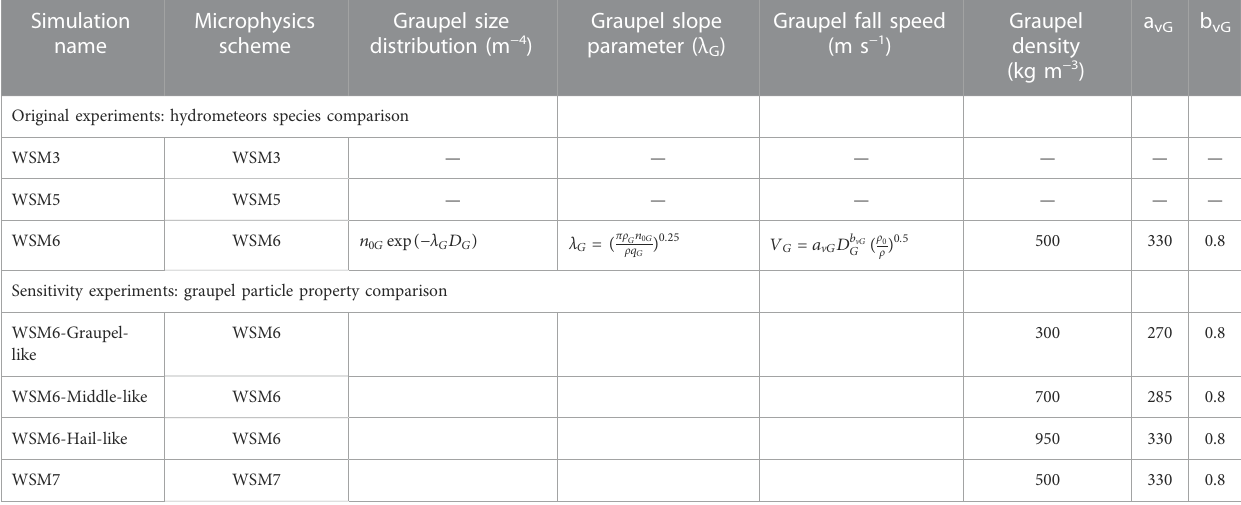
TABLE 1 Model experimental design and characteristics of graupel particle conducted in this